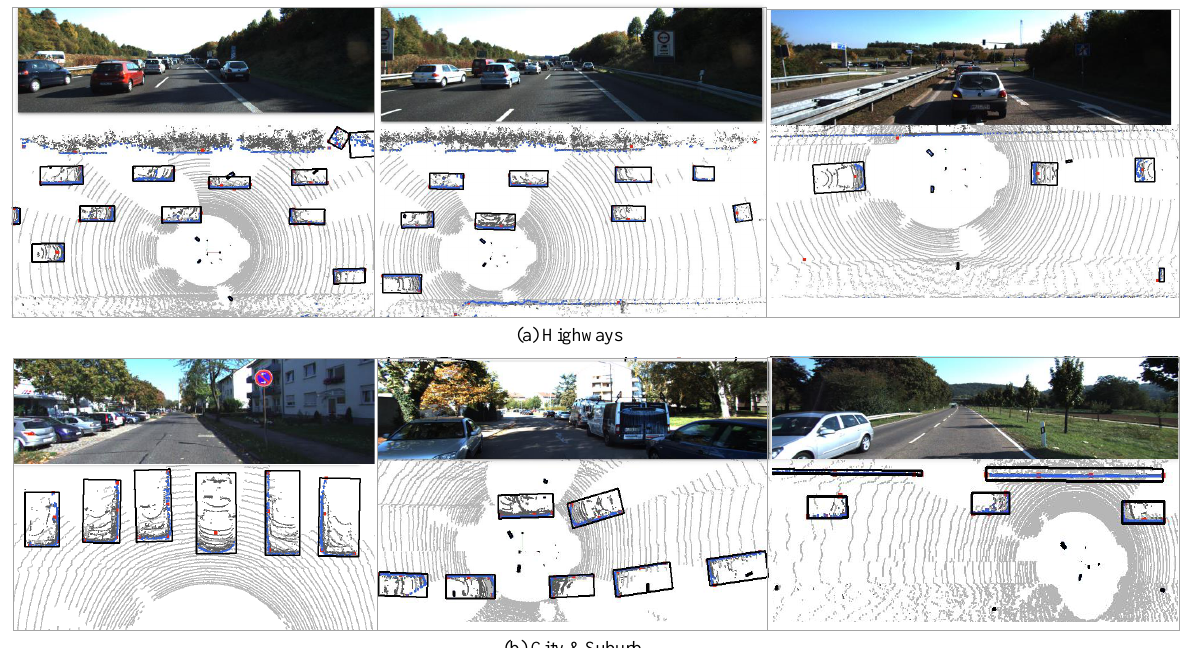
Figure 8. Visualizations of PE-HL-PF results on KITTI set. (best viewed in color with zoom-in) ( a ) represents the result in the highway scenario, ( b ) denotes the result in the city and suburb